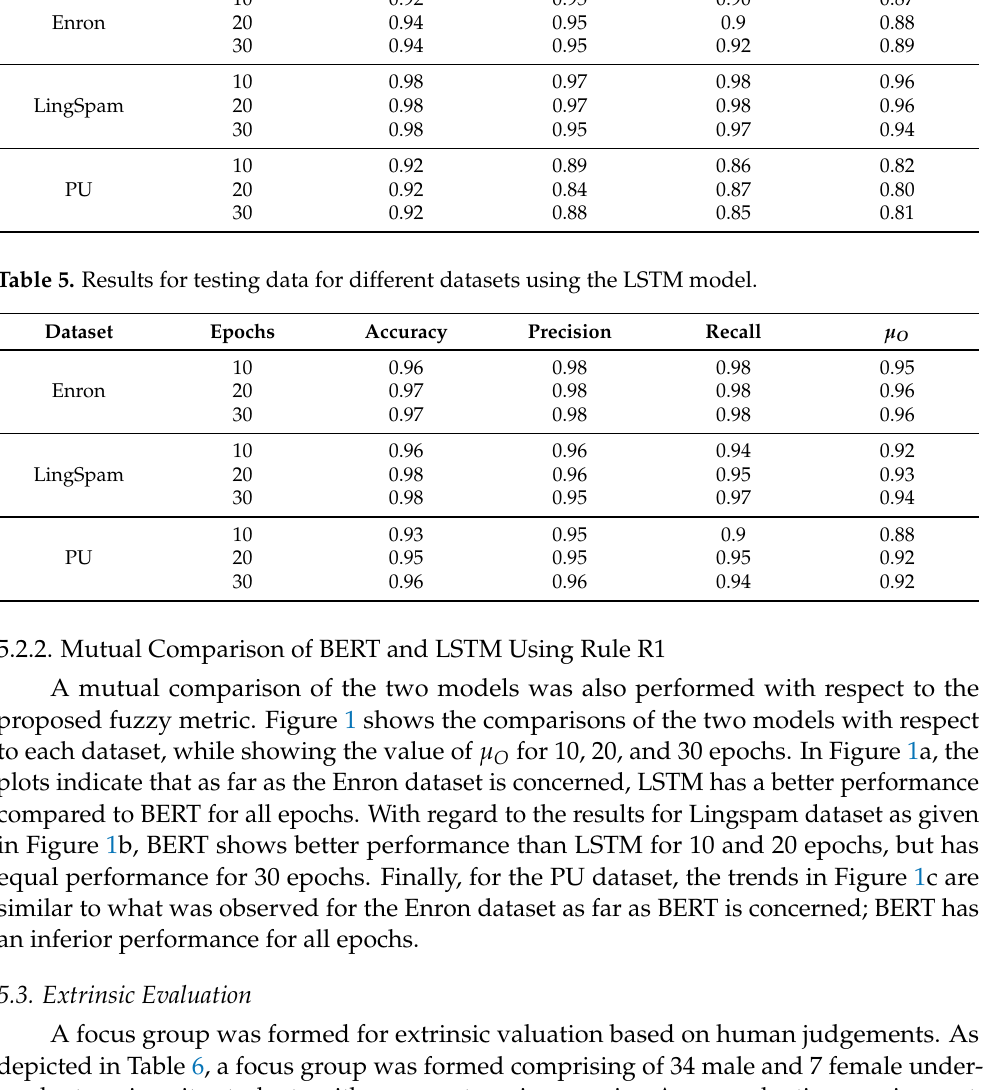
Table 4. Results for testing data for different datasets using the BERT model. Dataset